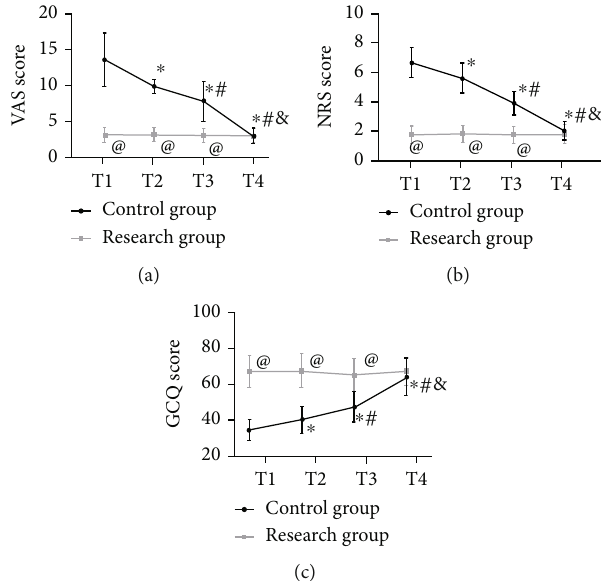
Figure 4: Comparison of comfort. (a) VAS score during treatment. (b) NRS score during treatment. (c) GCQ score during treatment. ∗ Di ff erence vs. the T1. # Di ff erence vs. the T2; & di ff erence vs. the T3; @ di ff erence vs. the control group. VAS: visual analogue scale; NRS: numerical rating scale; GCQ: general comfort